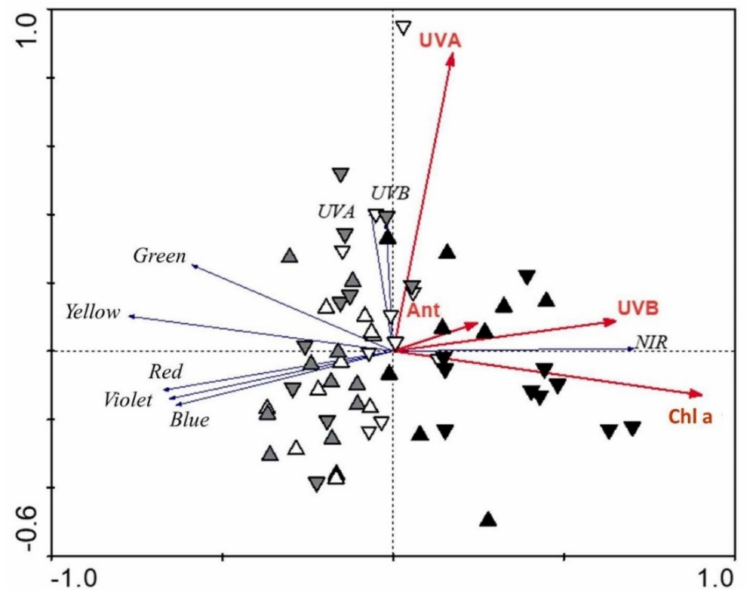
Figure 3. Redundancy analysis plot showing the strength of the associations between the sepal traits and different regions of the reflectance spectra for H. niger (up-triangles) and H. odorus (down-triangles). White triangles—developing phase; grey triangles—flowering phase; black triangles—fruiting phase. Only significant sepal parameters are shown. Chl a—chlorophyll a ;